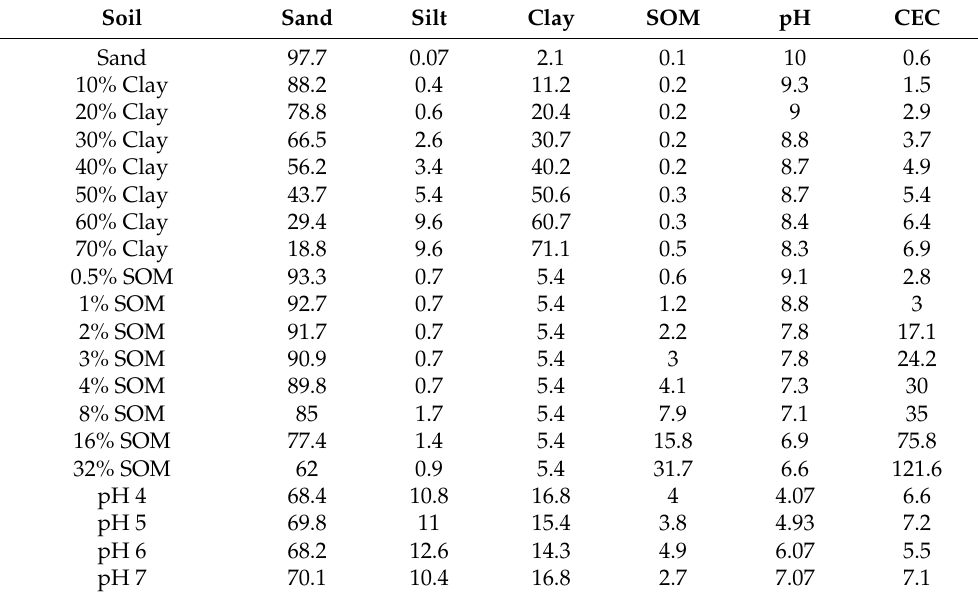
Table 1. Properties of the soils used to evaluate the efficacy of flumioxazin on Echinochloa crus-galli , Setaria faberi , Amaranthus retroflexus , and Abutilon theophrasti a .